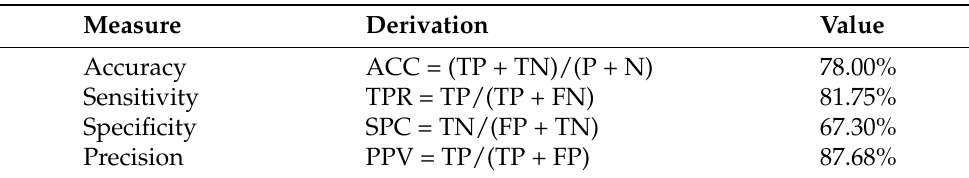
Table 3. Confusion matrix measurements for fish detection.